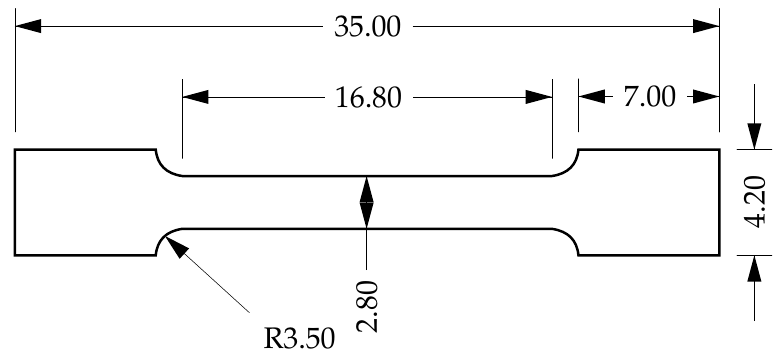
Figure 3. Technical drawing of the specimens used in tensile testing, lengths in mm. Scaled from type H geometry of